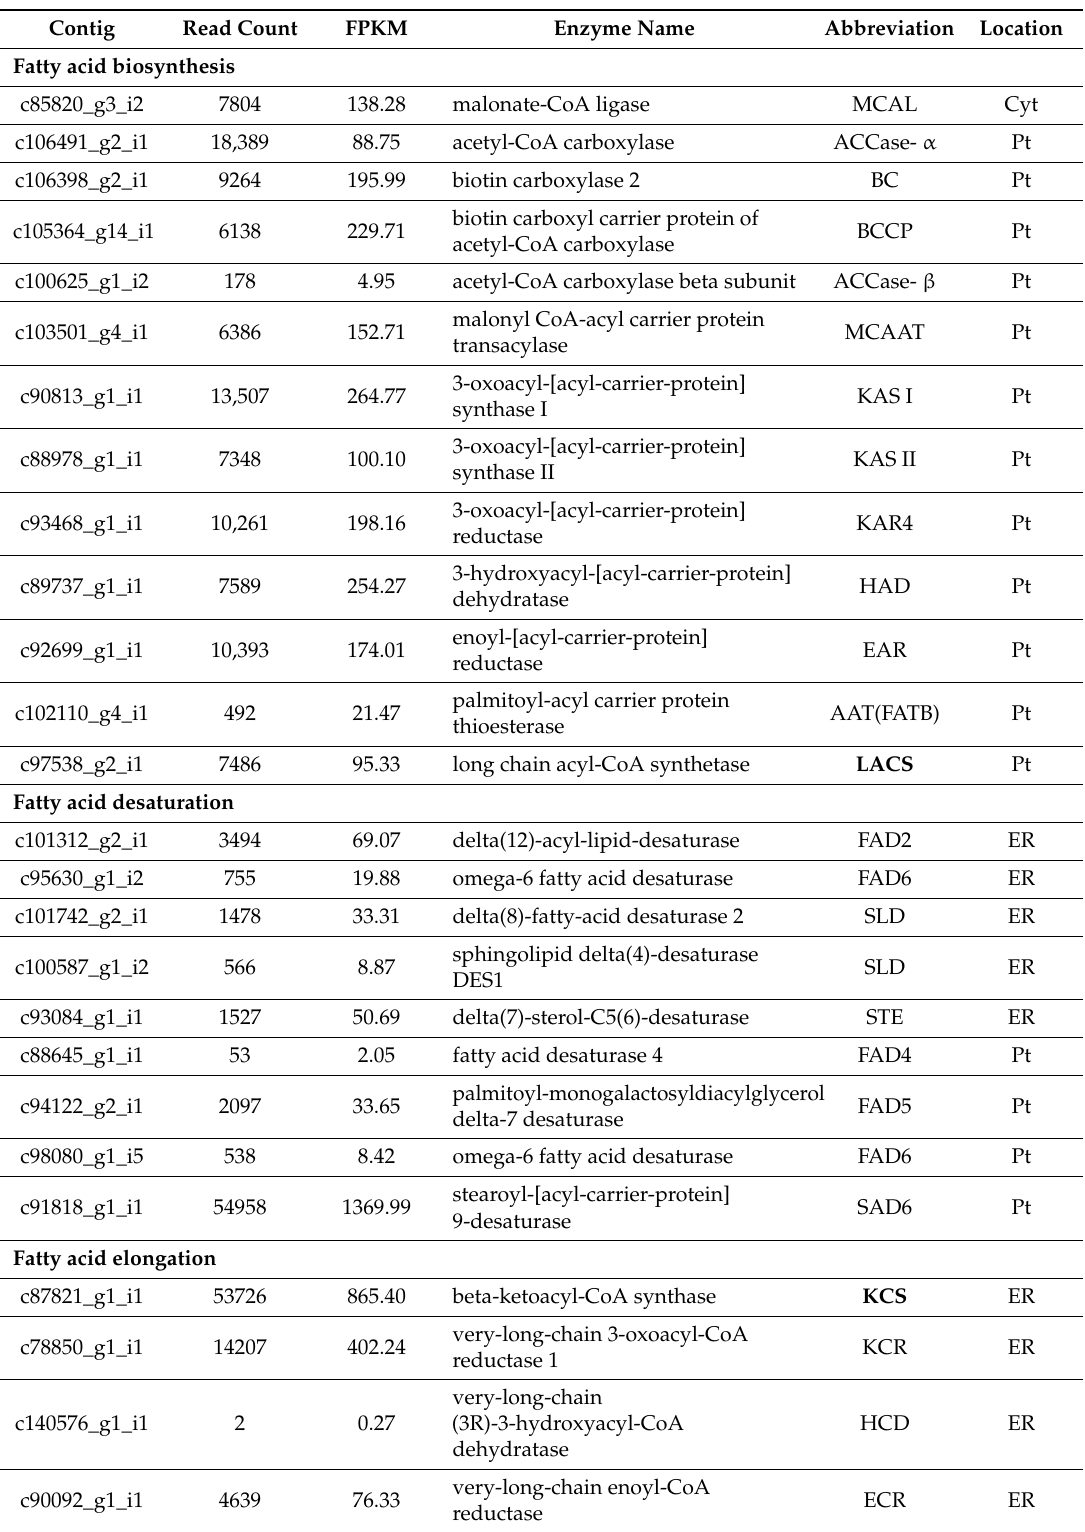
Table 2. Lipid biosynthesis enzymes detected in jojoba transcriptome during seed development. Contig Read Count